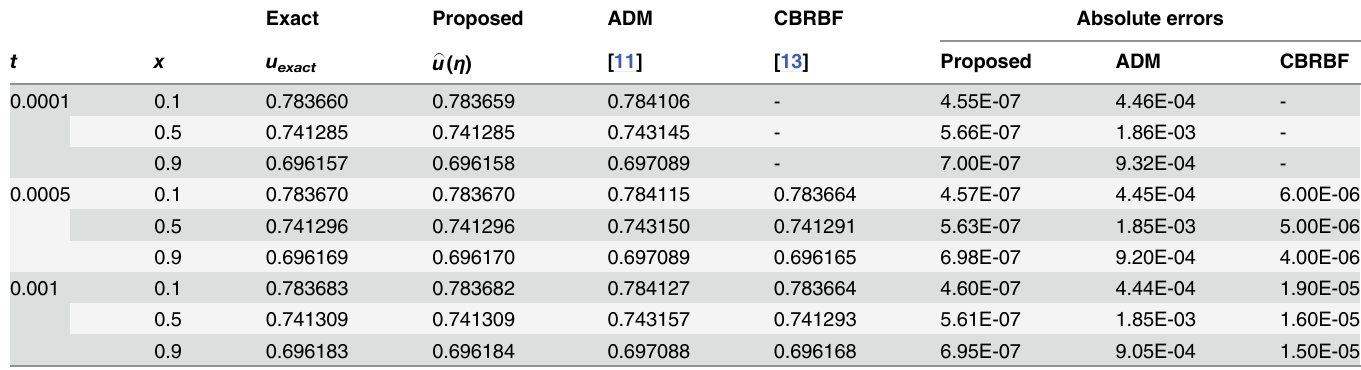
Table 12. Numerical solutions of generalized Burgers 0 equation by the proposed scheme and comparison with exact solutions, ADM [11], and CBRBF[13] for, α = 1, β = 0, and δ = 3. Exact Proposed ADM